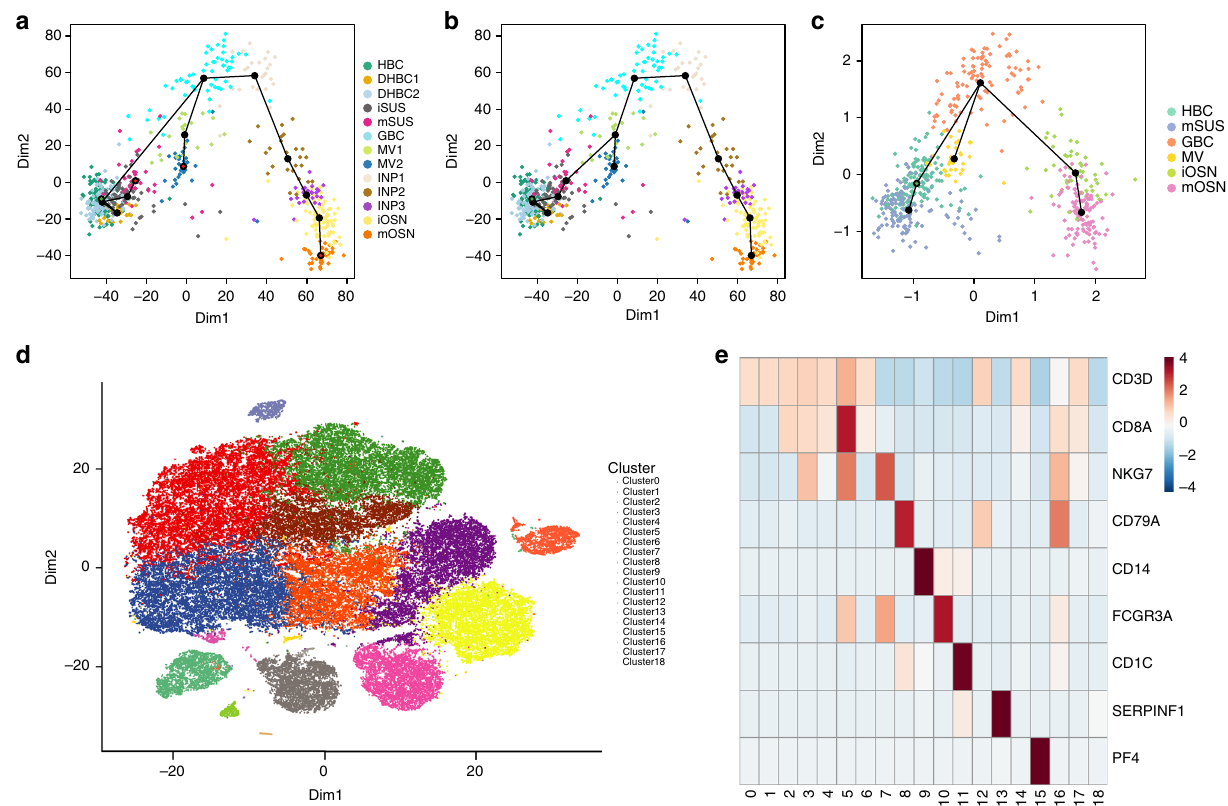
Fig. 3 Using ZINB-WaVE to gain novel biological insights. a – c Lineage inference on the OE data set. Slingshot minimum spanning tree on cell clusters: a PCA with endpoint supervision (marked as red nodes in the tree). b PCA with no endpoint supervision. c ZINB-WaVE with no endpoint supervision. a , b RSEC clustering (see Methods) on the fi rst 50 PCs of the normalized counts led to 13 clusters; c the same procedure on 50 components of W from ZINB-WaVE led to six clusters: horizontal basal cells (HBC); tran- sitional HBC (DHBC1-2); immature sustentacular cells (iSUS); mature sustentacular cells (mSUS); globose basal cells (GBC); microvillous cells (MV); immediate neuronal precursors (INP1-3); immature olfactory neurons (iOSN); mature olfactory neurons (mOSN). mOSN, MV, and mSUS are the mature cell types and should be identi fi ed as the three lineage endpoints. d , e Discovery of rare cell types for the 10× Genomics 68k PBMCs data set. d Scatterplot of fi rst two t-SNE dimensions obtained from 10 components of W from ZINB-WaVE; cells are color-coded by cluster. Clustering was performed on the 10 components of W (see Methods). e Heatmap of expression measures for marker genes for the 18 clusters found by our procedure: columns correspond to clusters and rows to genes; the value in each cell is the average log expression measure per cluster, centered and scaled so that each row has mean zero and standard deviation